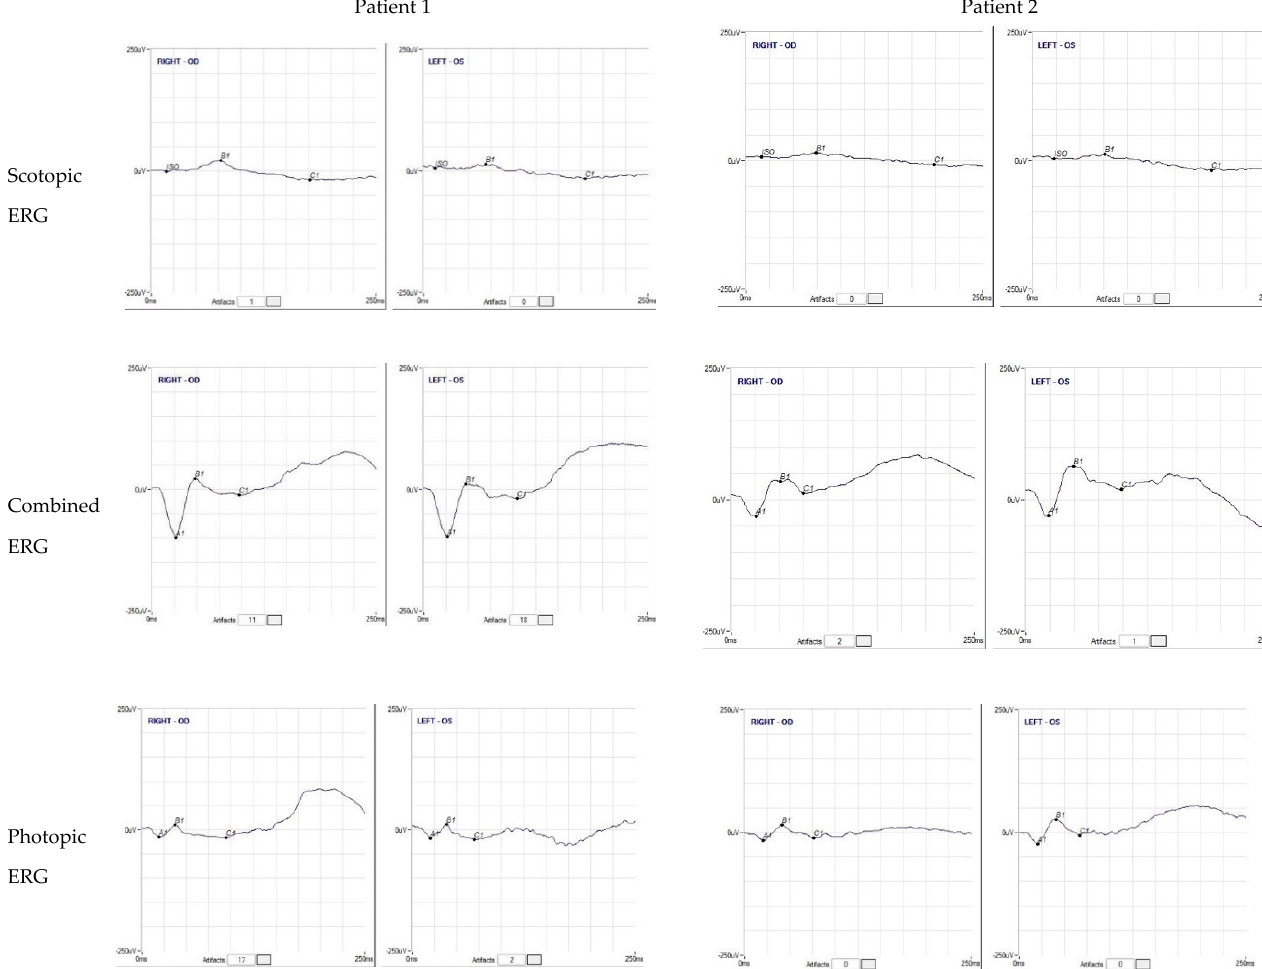
Figure 3. ERG responses. ERG recordings showing severely reduced responses for the scotopic stimulus and reduced responses for the combined and photopic stimuli with a decreased b-wave to a-wave ratio. Representative examples of ERG responses from a normal subject are shown for comparison.